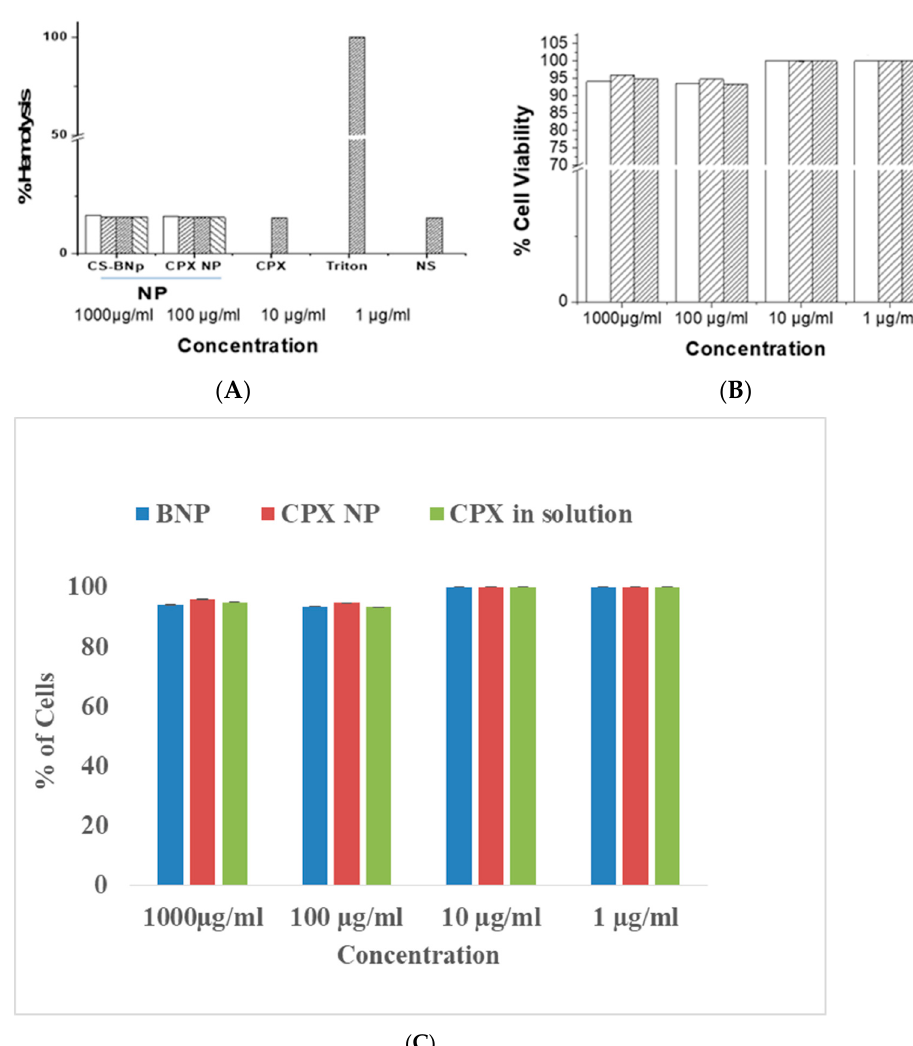
Figure 5. Toxicity assay after cells were exposed to CPX-loaded nanoparticles. ( A ) The trypan blue dye exclusion assay in 3T3 cells exposed todifferent doses of CPX, CPX-NPs, or blank NPs (1, 10, 100, and 1000 μ g/mL); ( B ) hemolysis assay to assess membrane damage by CPX-loaded NPs; ( C ) neutral red dye uptake assay, cells exposed tociprofloxacin (CPX), chitosan blank nanoparticles (BNPs), and CPX-loaded chitosan nanoparticles (CPX-CS NPs) at different concentrations. Triton X-100 0.1% used as a positive control and normal saline (NS) used as negative control.